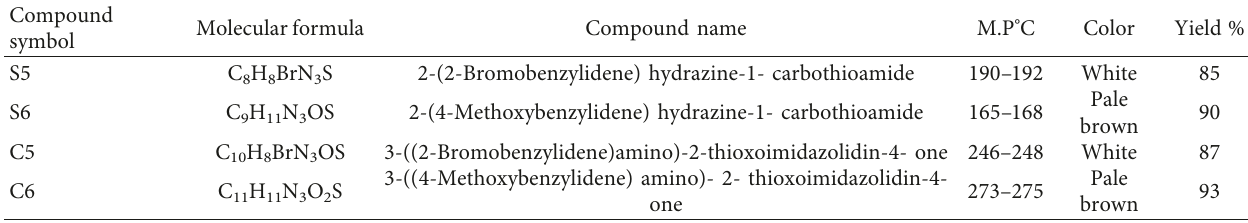
Table 1: Physical properties and yield percentage of compounds S5, S6, C5, and C6.